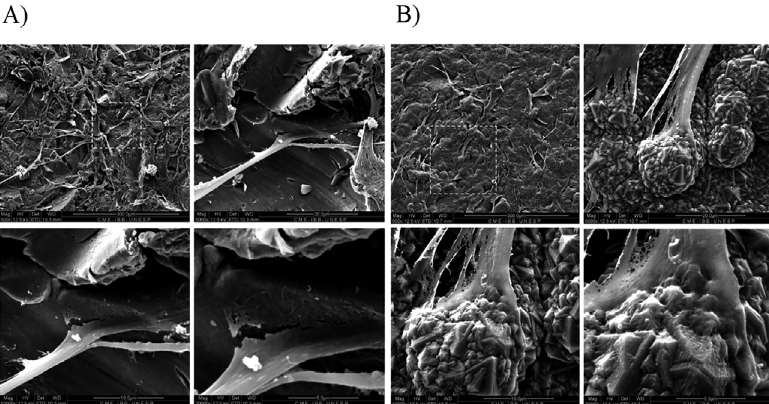
Figure 10. Scanning electron microscopy of fibroblast cells on rough titanium without diamond